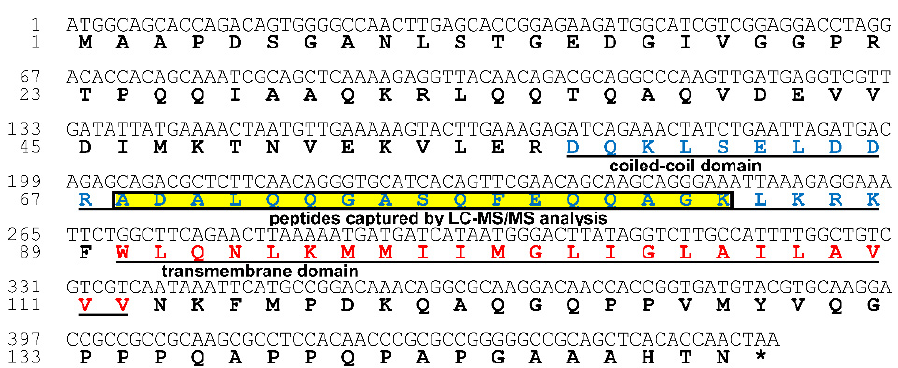
Figure 1. The deduced amino acid sequence of MEAM1 VAMP2. The underlined blue amino acids indicate a coiled coil domain; the underlined red amino acids indicate a transmembrane domain. The yellow boxed sequence represents the peptides captured by Co-IP coupled with LC-MS/MS assays.